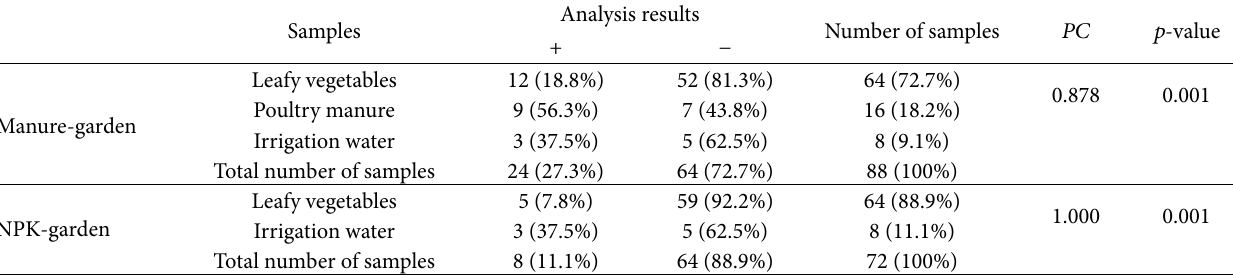
Table 2: Contamination rate of samples from Sèmè-Kpodji vegetable farm.